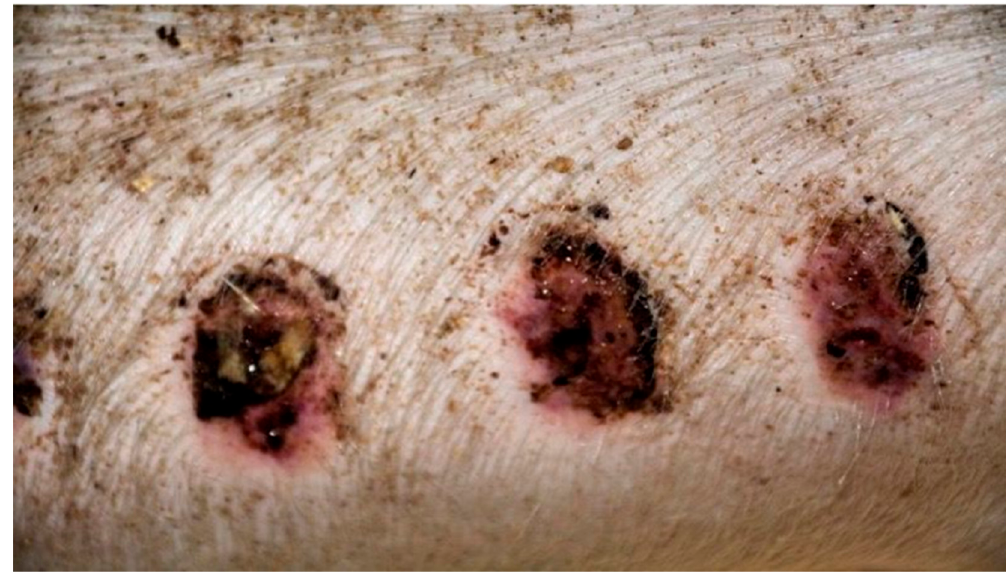
Figure 6. Group D2—burn wound treated with the 1% nanosilver ointment on day 15.